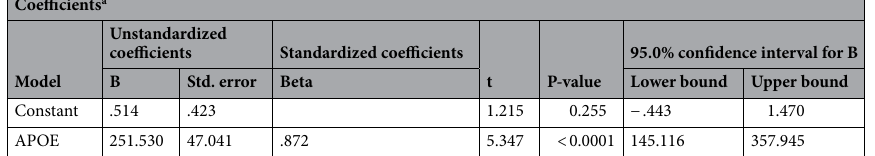
Table 5. Logistic regression analysis to show the association of number of anti-VEGF injection on APOE expression in AMD pathology in retrospectively analyzed AMD patients. a Dependent variable: anti-VEGF number.